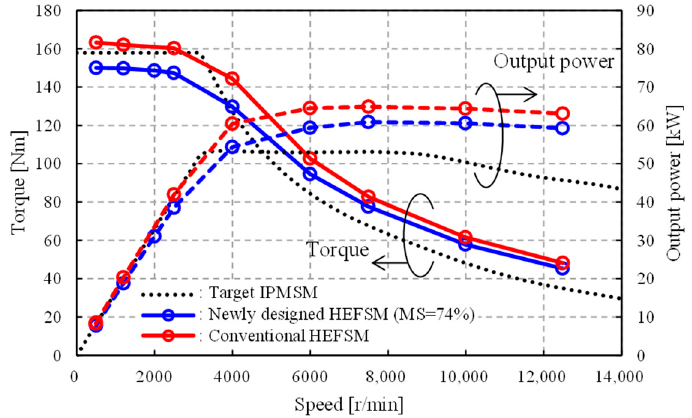
Figure 14. Measured maximum torque and power vs. speed curves.